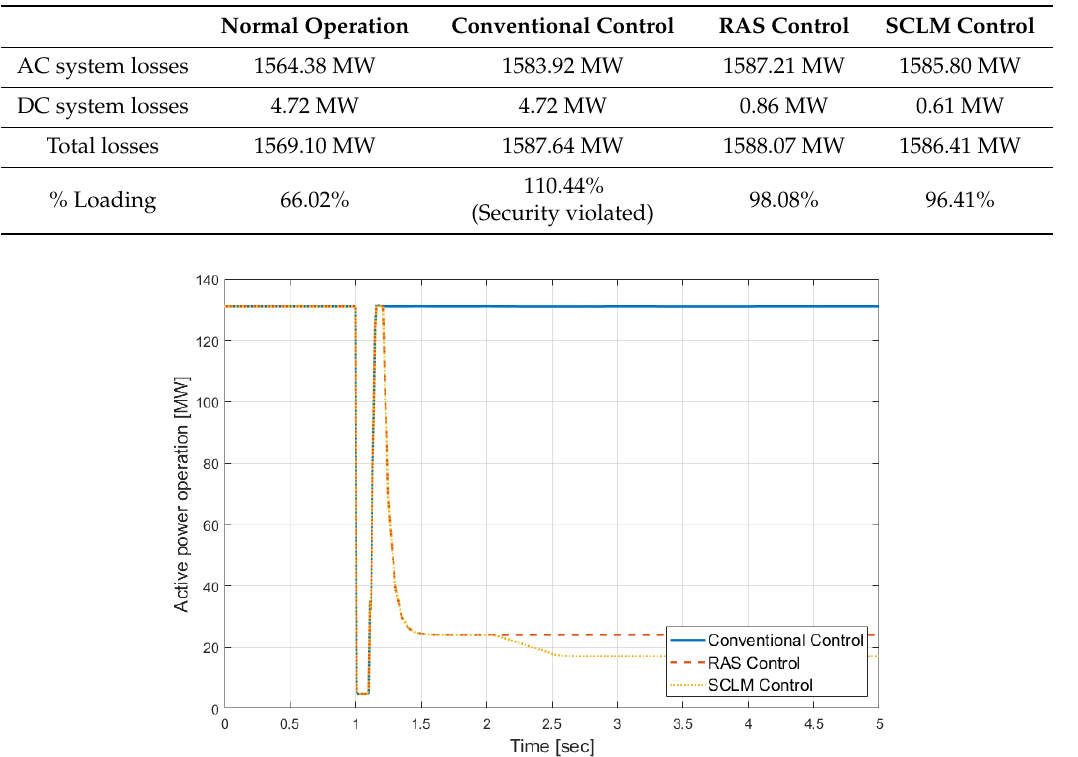
Figure 8. Active power operation change in the transformer overload case.